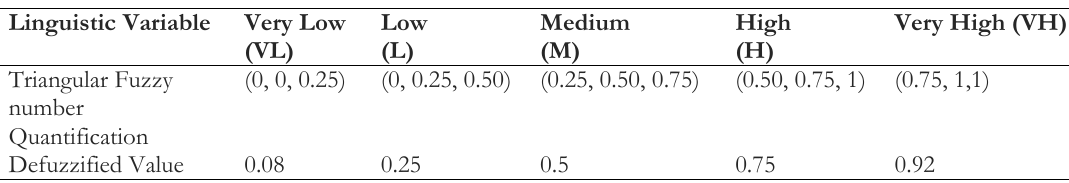
Table 3. The quantified triangular fuzzy numbers.